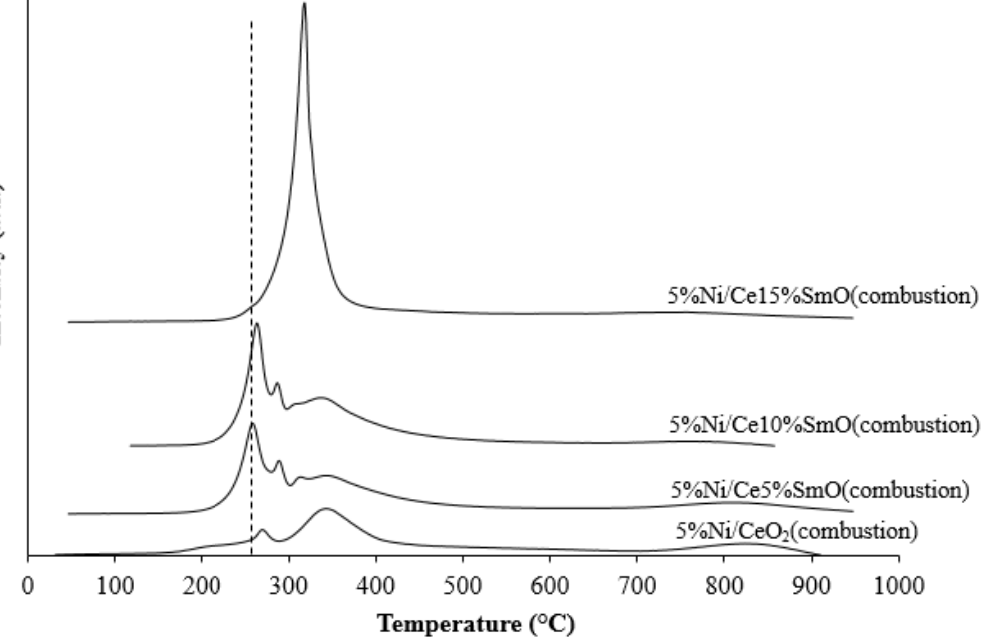
Table 2. The surface area and dispersion of metallic Ni prepared by different methods. Catalysts